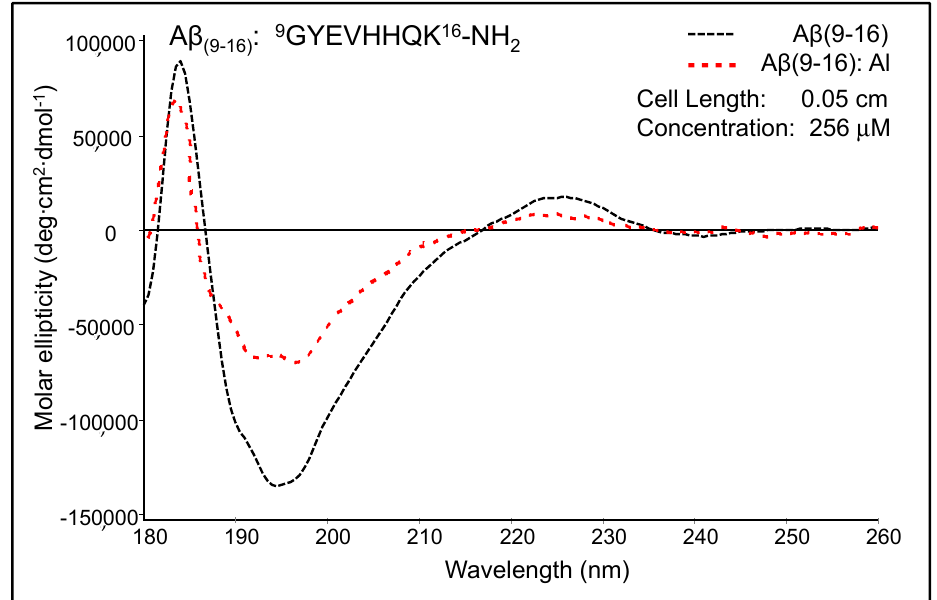
Figure 4. The effect of aluminium ions on the circular dichroism (CD) spectrum of A β (9–16) peptide (pH 7.4; (1:1 Al:A β (9–16) peptide molar ratio).